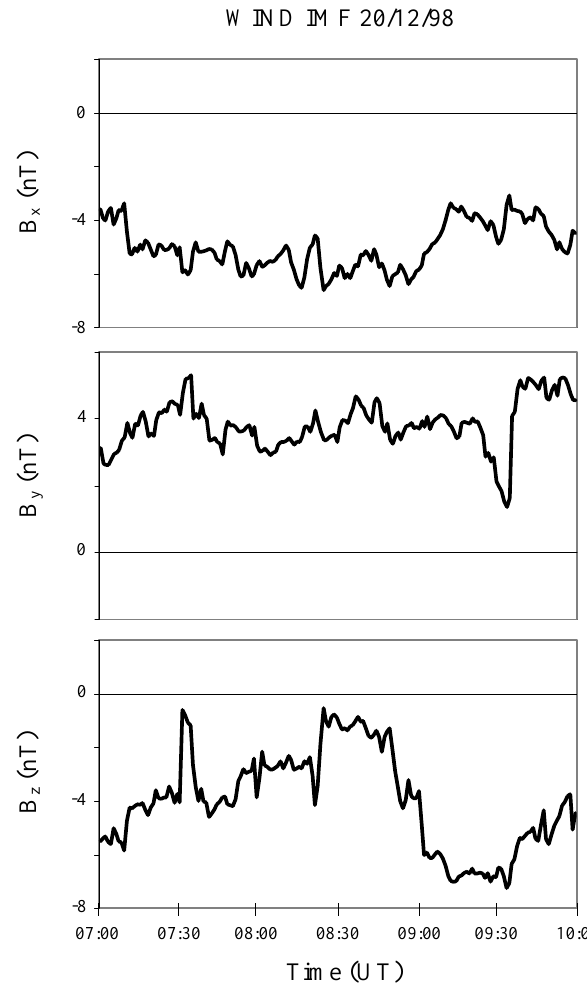
Fig. 4. The three components of the IMF measured by the WIND spacecraft located in the solar wind, between 07:00 and 10:00 UT on 20 December